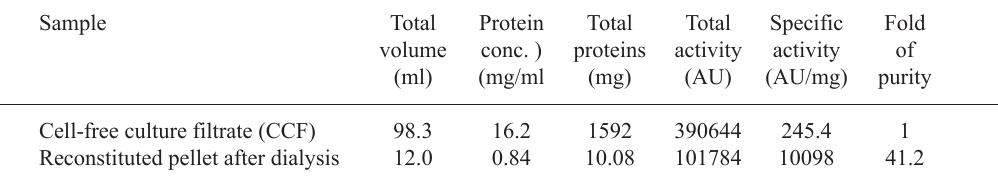
Table 3c. Activity against Acinetobacter baumannii MTCC 1425